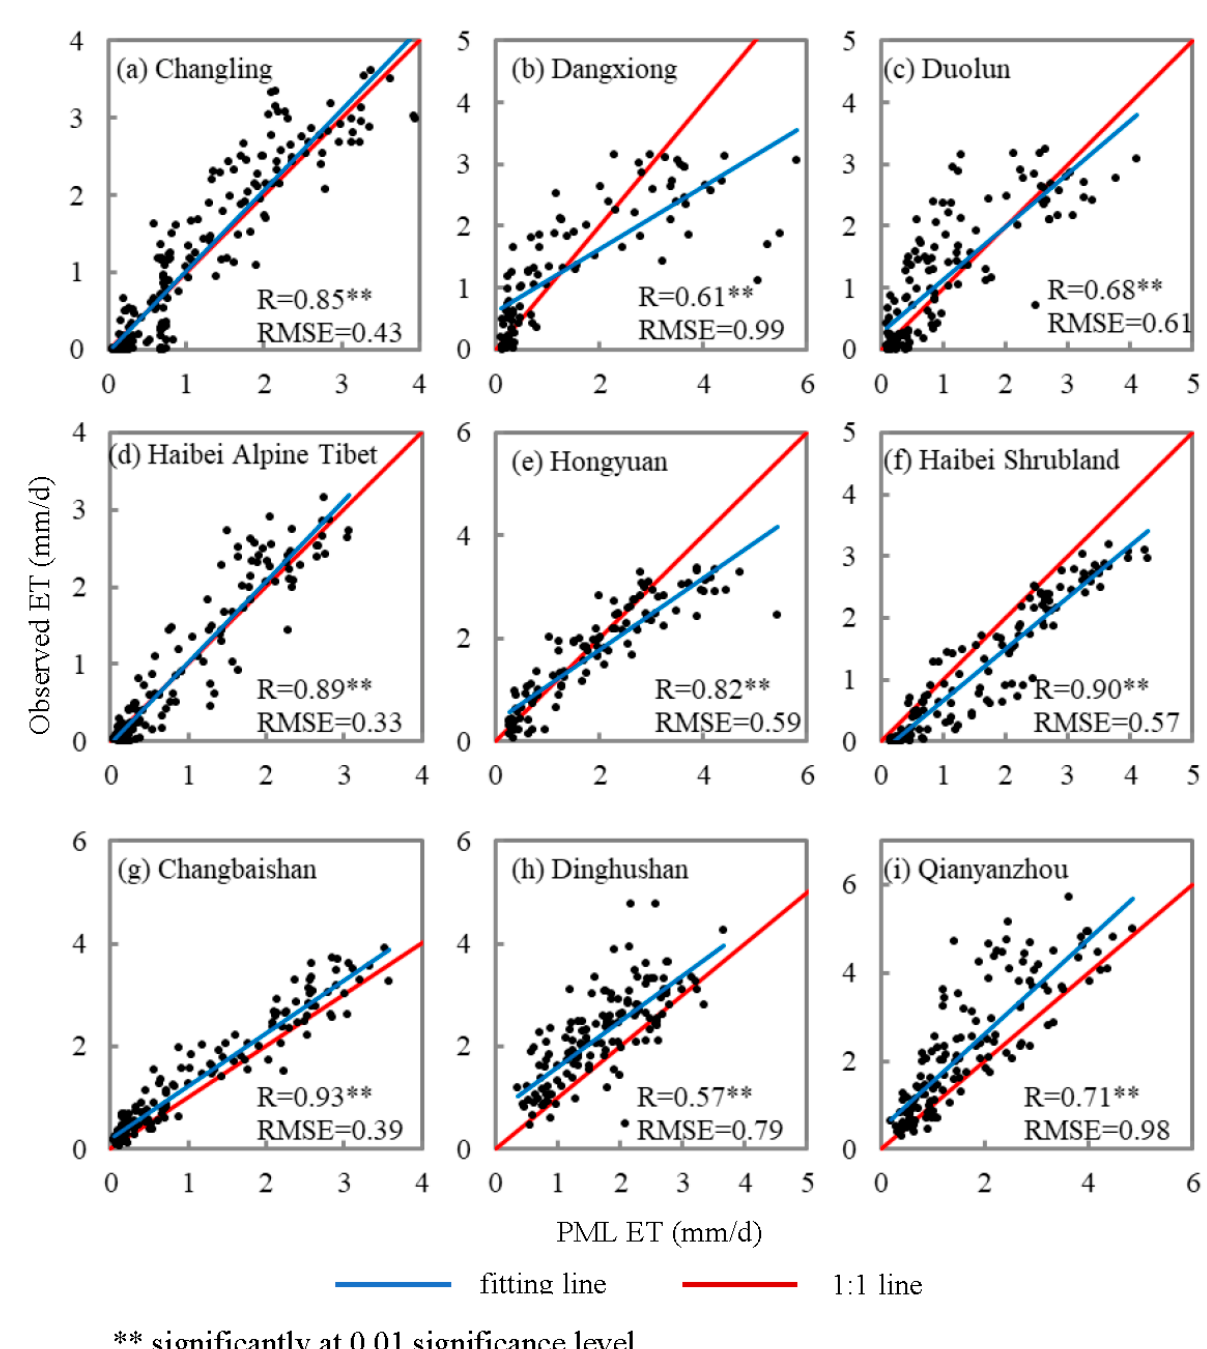
Figure 2. The scatter plots of the estimated ET by PML model vs. the eddy flux data in China.